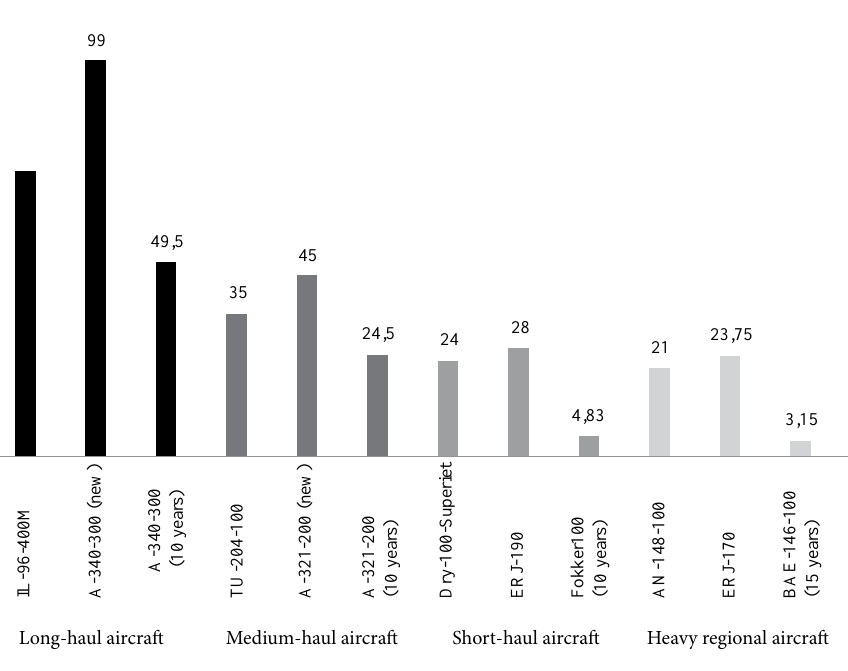
Fig. 2. Cost of Aircraft in the World Market, millions USD (Aralov